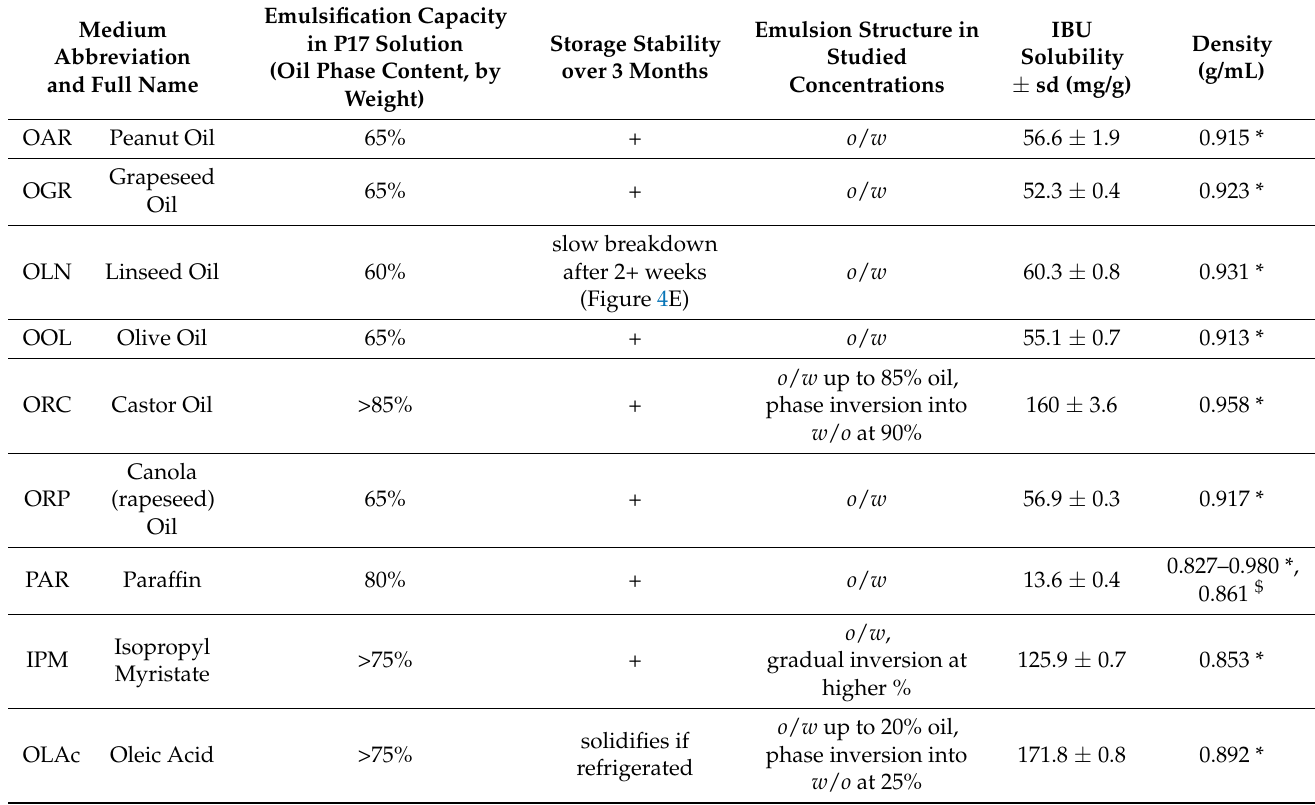
Table 1. Summary of media